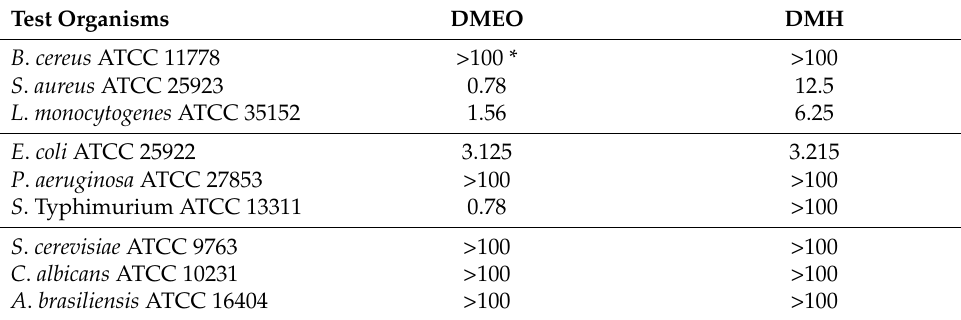
Table 4. Minimal inhibitory concentration (%).